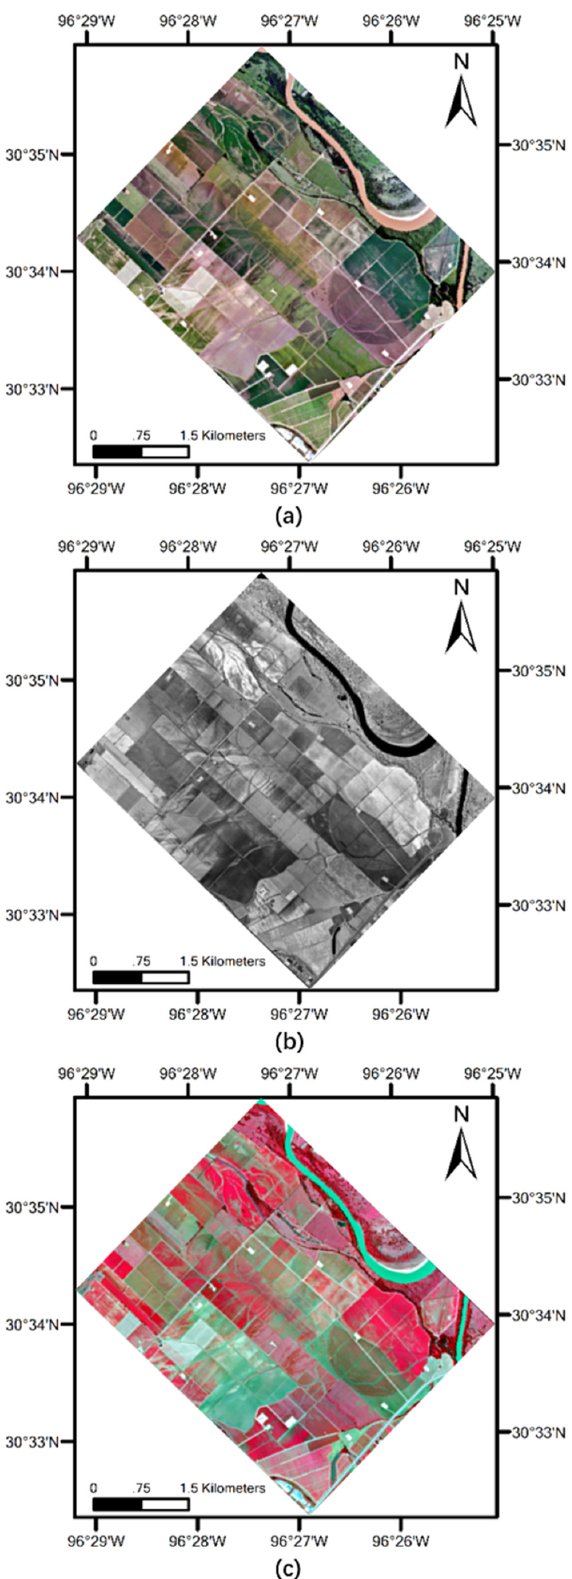
Figure 4. Mosaicked images for this study: ( a ) three-band RGB image, band 1 = blue, band 2 = green and band 3 = red; ( b ) NIR band image; and ( c ) CIR composite (NIR, red and green) extracted from the four-band image, band 1 = blue, band 2 = green, band 3 = red and band 4 = NIR.